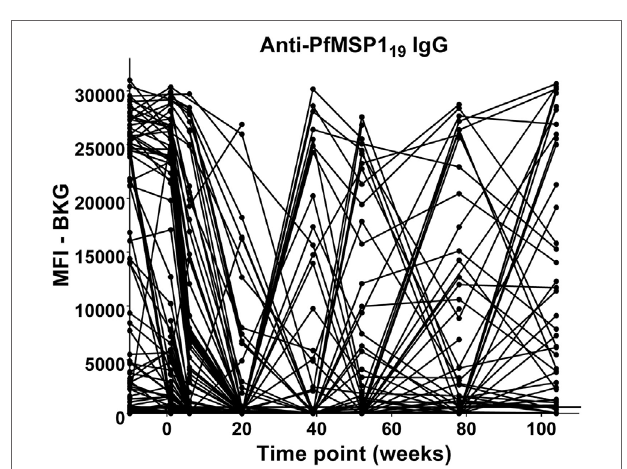
FigUre 5 | Time course of IgG antibody responses to soluble egg antigen (SEA) of Schistosoma mansoni among infants from birth to 2 years. x -Axis shows time of sample collection, calculated from birth in weeks. Maternal antibody response is shown at − 10 weeks. Neonatal first bleed is shown at 1 week and subsequent bleeds are at 6 weeks and 5, 9, 12, 18, and 24 months. MFI, median fluorescence intensity; BKG, background. Horizontal line shows optimal cutoff (267) for positive antibody responses to S. mansoni SEA.